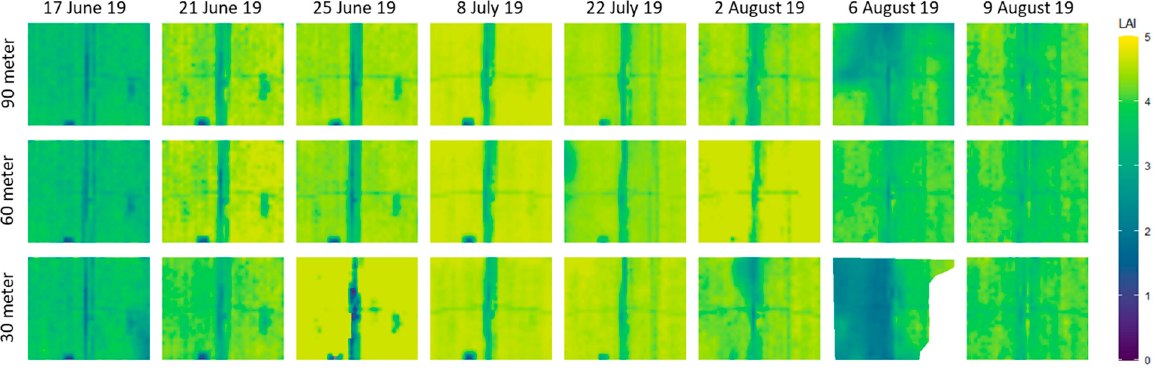
Figure 4. LAI (m 2 m − 2 ) raster maps derived from Enhanced Vegetation Index for each